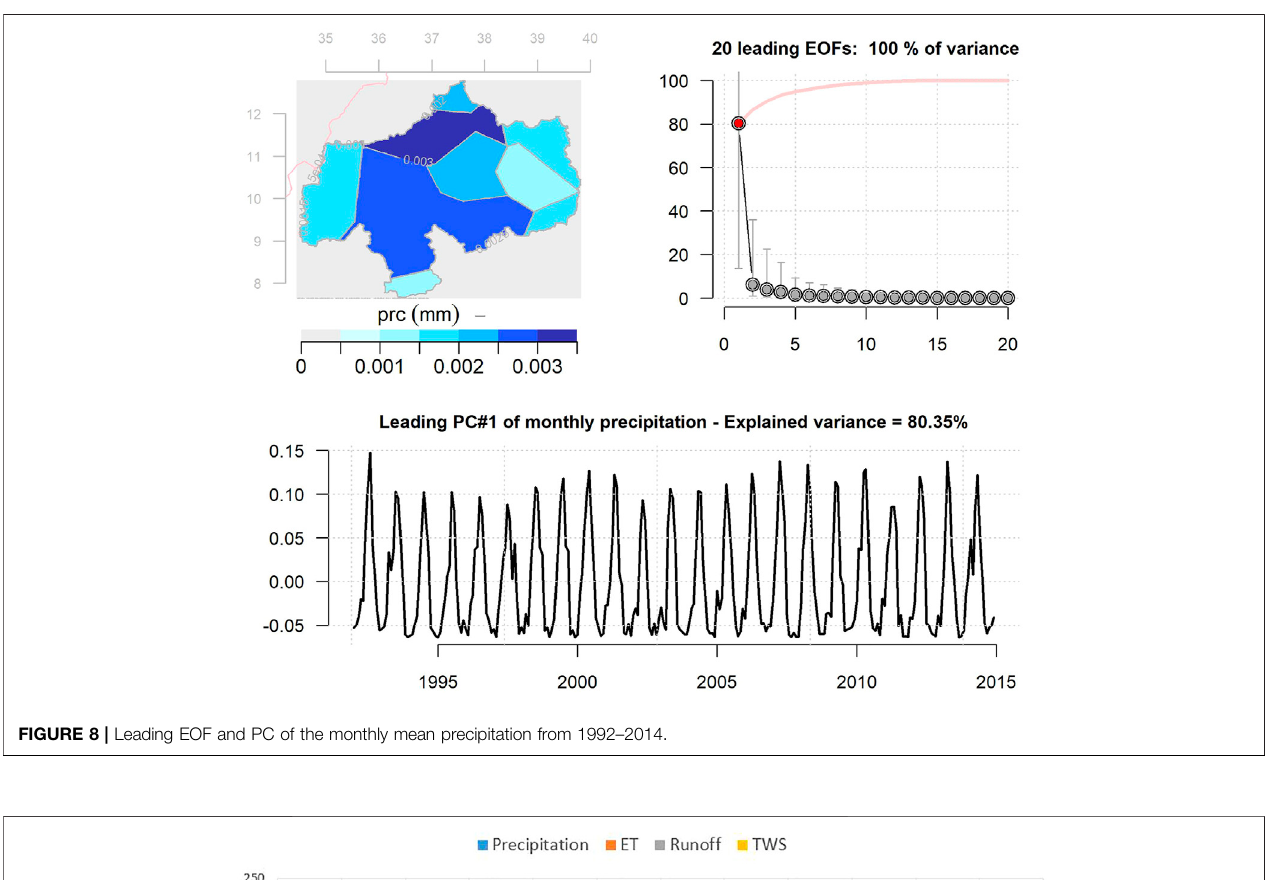
FIGURE 8 | Leading EOF and PC of the monthly mean precipitation from 1992 – 2014.